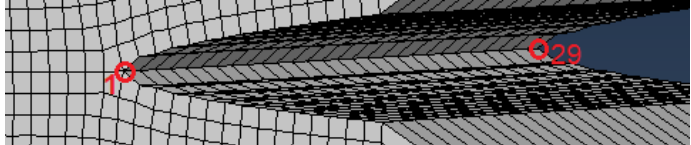
Figure 9. Mesh of the bare steel CT specimen: identification of node number through crack thickness.